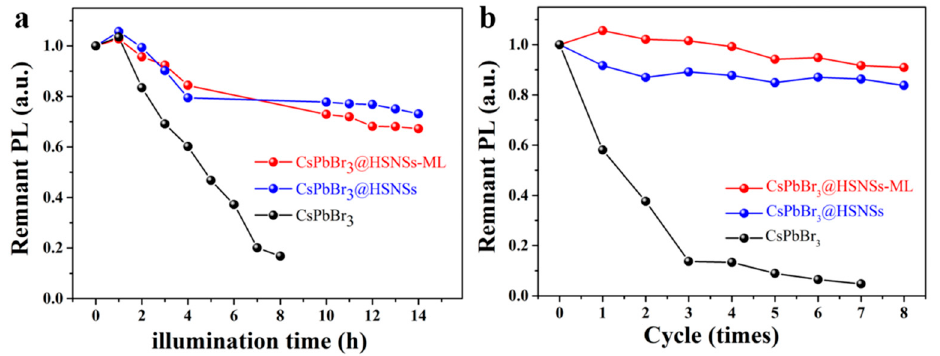
Figure 7. Variations of the PL intensity for CsPbBr 3 NCs, CsPbBr 3 @HSNSs, and CsPbBr 3 @HSNSs-ML under ( a ) a high temperature environment and ( b ) UV irradiation.